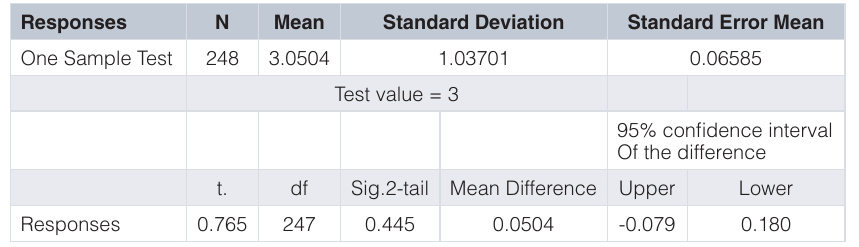
Table 5. Agricultural Extension Services and reduction in unemployment.